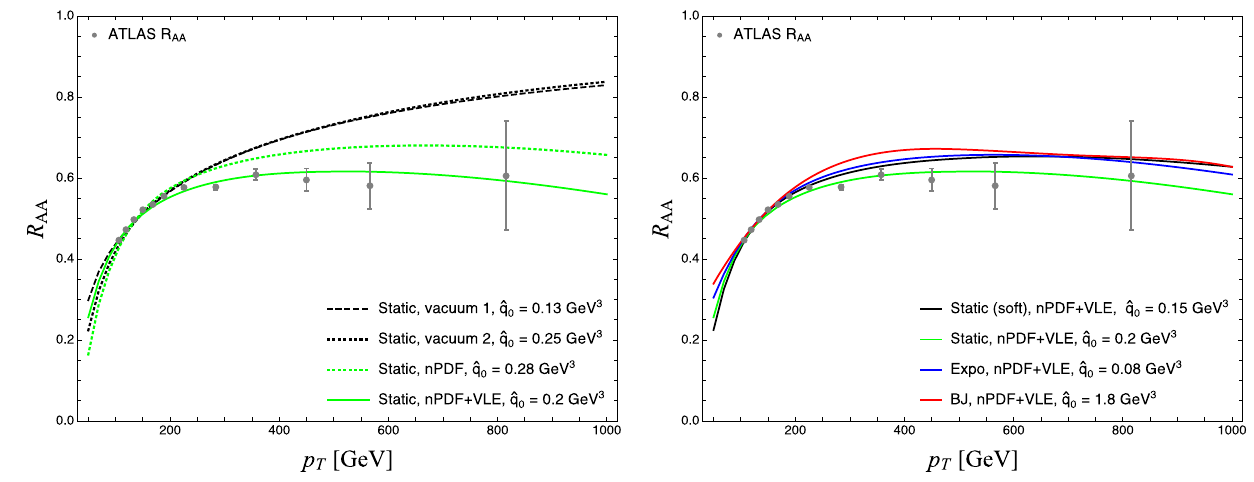
configurationforfourmediumprofiles:staticsoft(black),static(green), exponential (blue), and Bjorken with t 0 = 0 . 1 fm (red) The ˆ q 0 values were optimized for each profile to reproduce the data (in gray) [44]